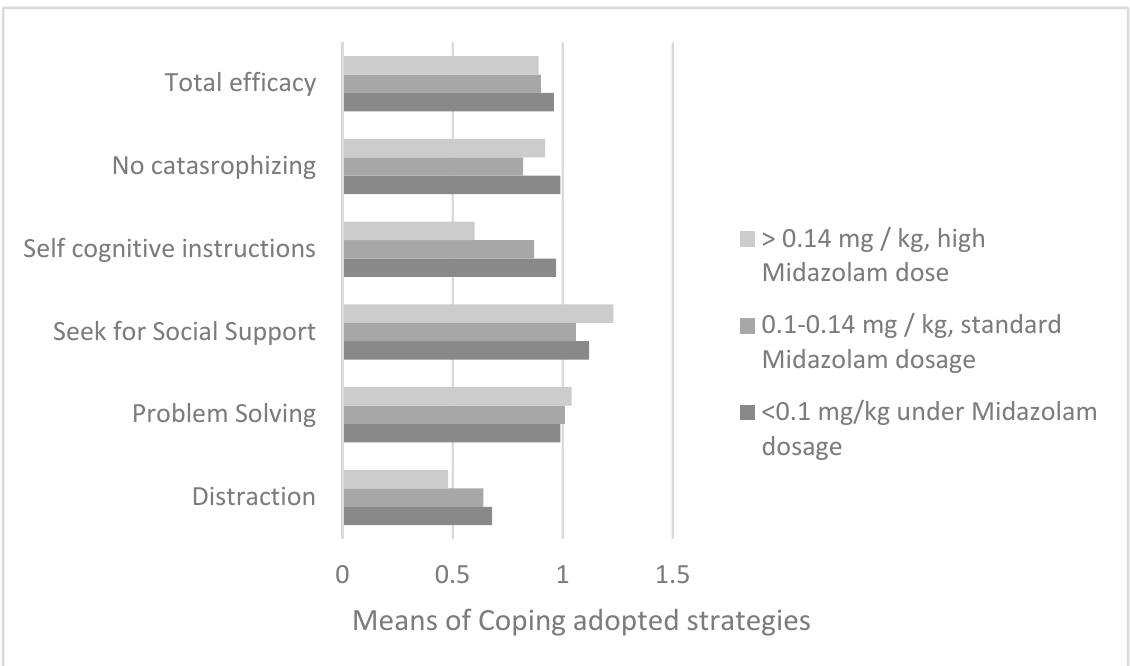
Figure 2. Comparison between the averages of the 5 coping strategies adopted along the average dosage of midazolam taken in the sedation induction phase for the diagnostic bone marrow aspirate.